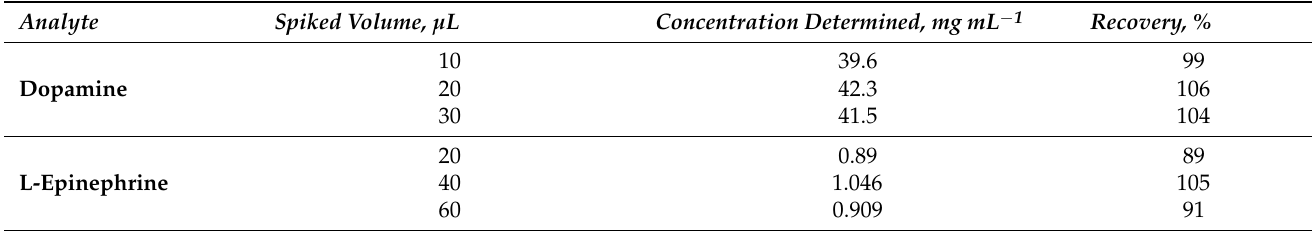
Table 4. Biosensor validation with real samples—injection solutions with known concentration